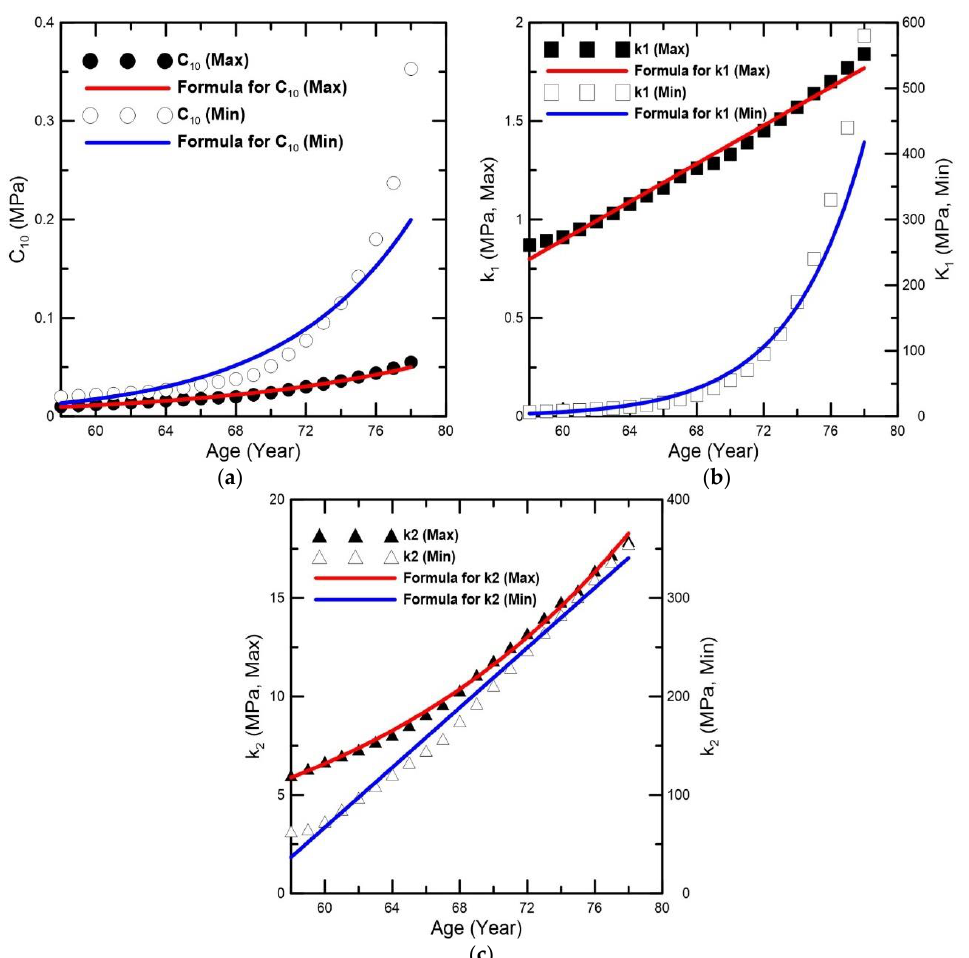
Figure 9. Comparison between material constants (( a ) C 10 , ( b ) k 1 , and ( c ) k 2 ) and formulae according to age. to